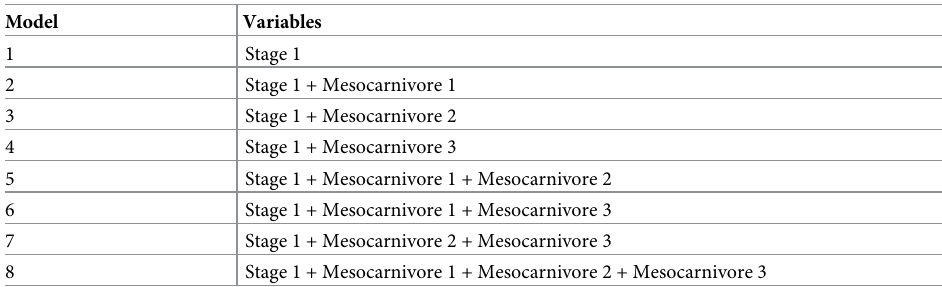
Table 2. Candidate models for multi-species occurrence.